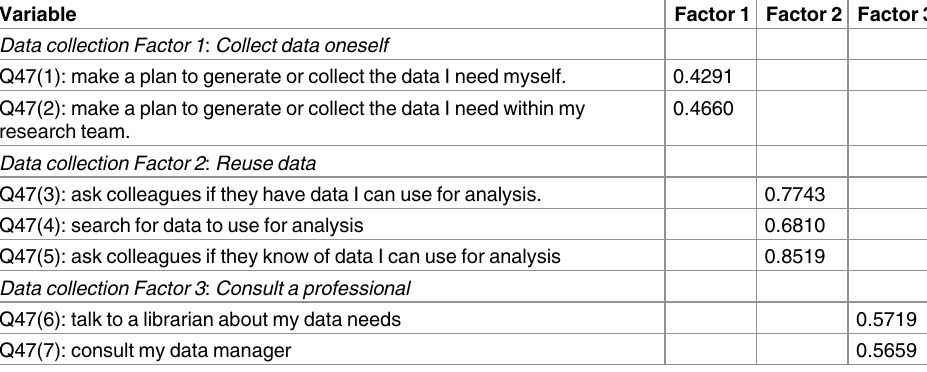
Table 1. Factor loading for reported modes of obtaining